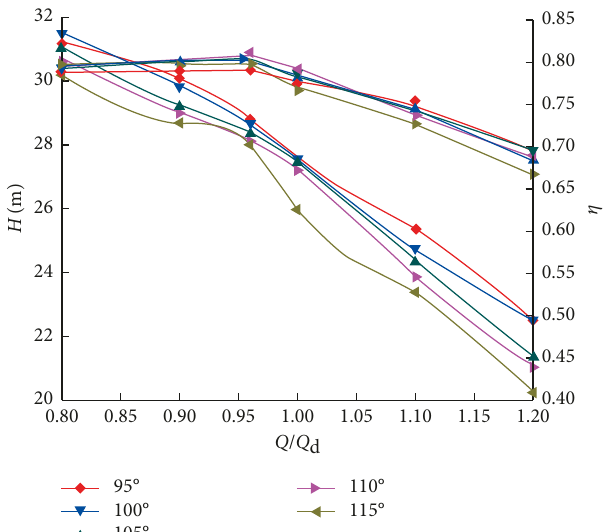
Figure 10: Centrifugal pump head: efficiency